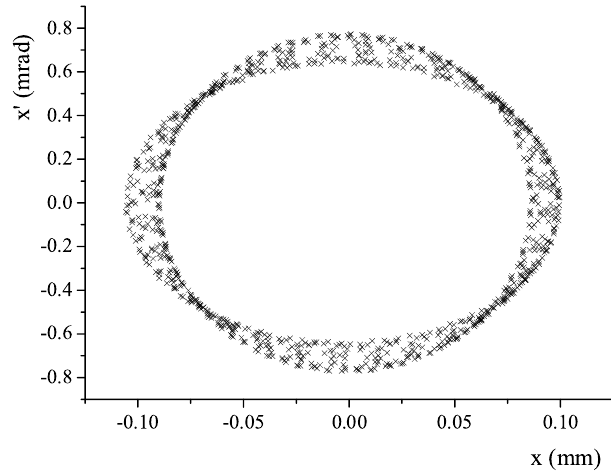
FIG. 6. Horizontal phase trajectory of a particle with large momentum deviation at IP azimuth in the operation mode with low momentum compaction factor (cid:12) ticle coordinates are x (cid:1) 0 : 01 (cid:8) ini